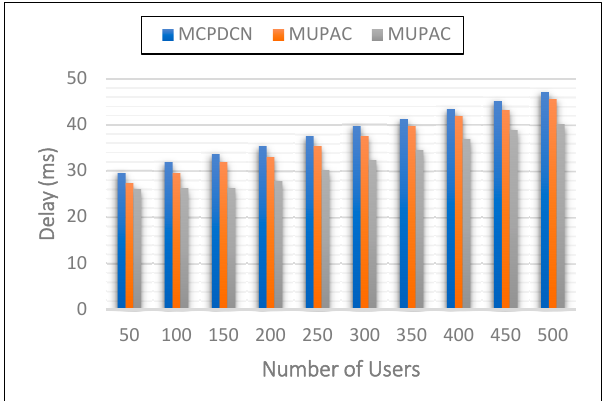
Figure 10. Cache hit ratio comparison in terms of user density.